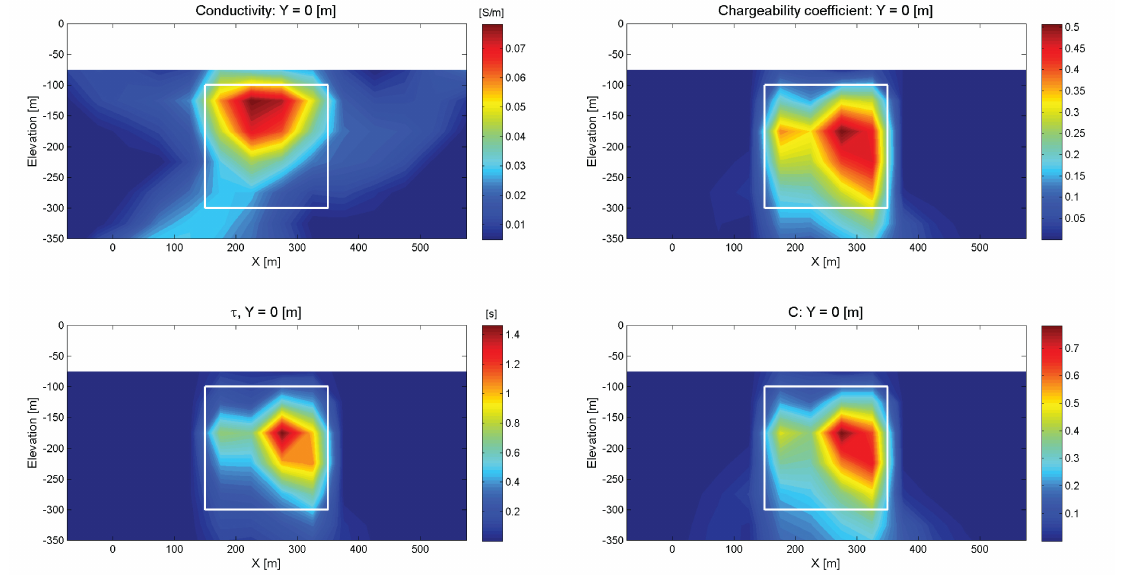
Figure 3. Vertical cross sections of the GEMTIP model parameters (DC anomalous conductivity, fraction volume, time constant, and relaxation parameter) recovered from the 3D inversion of time-domain SIP